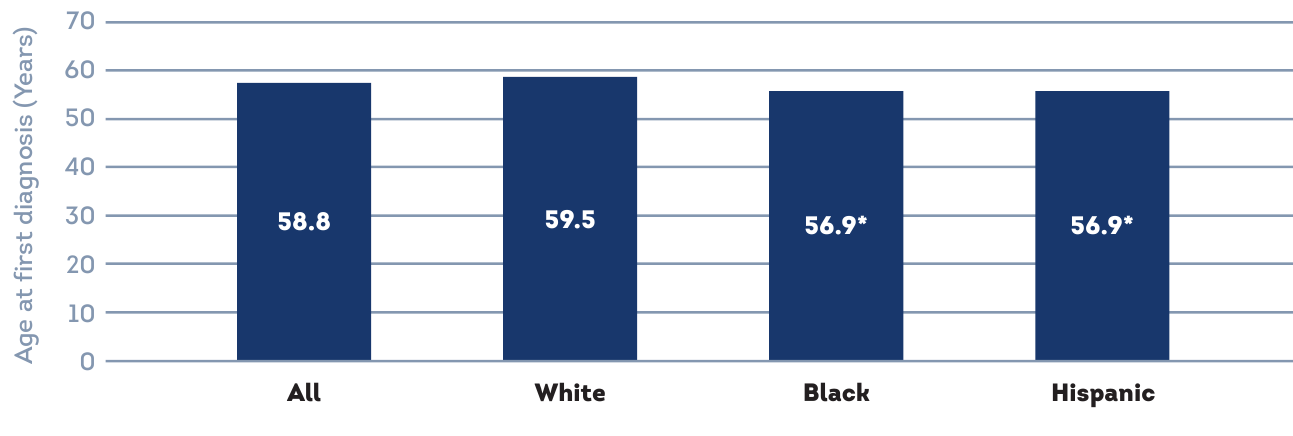
Figure 2. Age at first diabetes diagnosis, among community-dwelling Medicare beneficiaries with self-reported diagnosed diabetes, by race/ethnicity